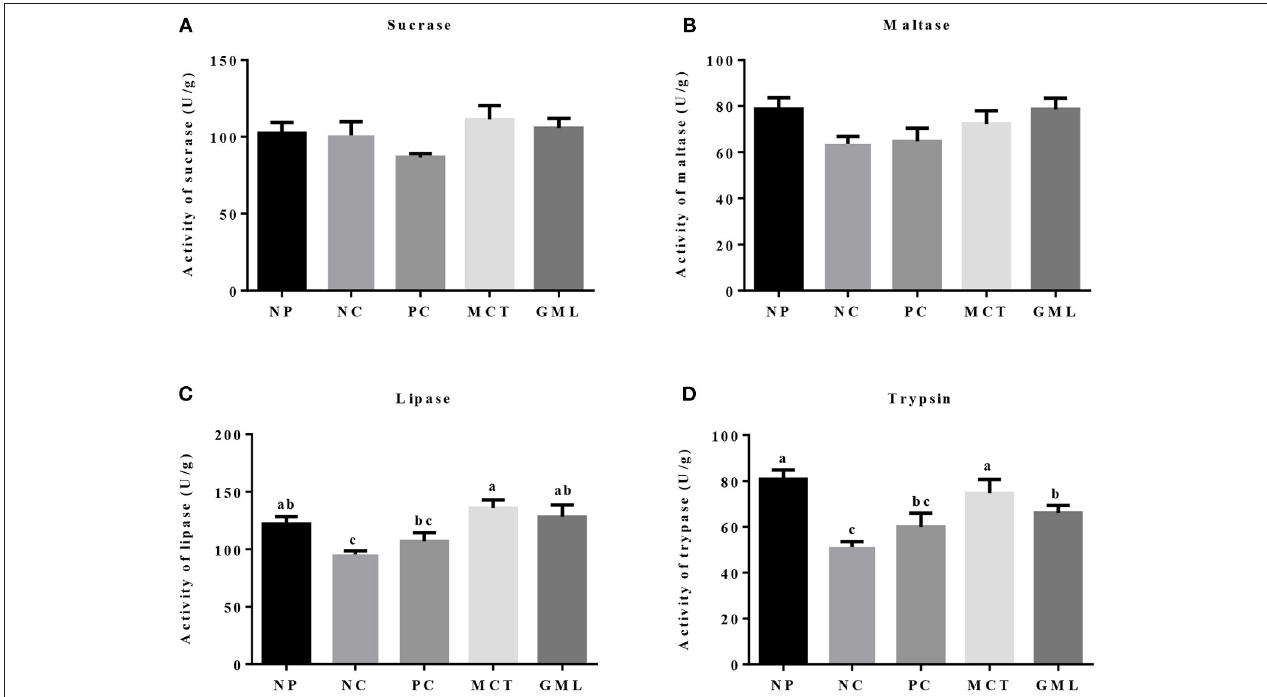
FIGURE 3 | (A–D) The ileal digestive enzyme activity. a − c Mean values sharing different superscripts within a row differ ( P < 0.05). Values are the mean ± SEM, n = 6. NP, normal protein basal diet no antibiotics included; NC, low-protein basal diet no antibiotics included; PC, low-protein basal diet + antibiotics (75 mg/kg quinocetone, 20 mg/kg virginiamycin and 50 mg/kg aureomycin); MCT, low-protein basal diet + 2 kg/T tricaprylin/tricaprin; GML, low-protein basal diet + 2 kg/T glycerol